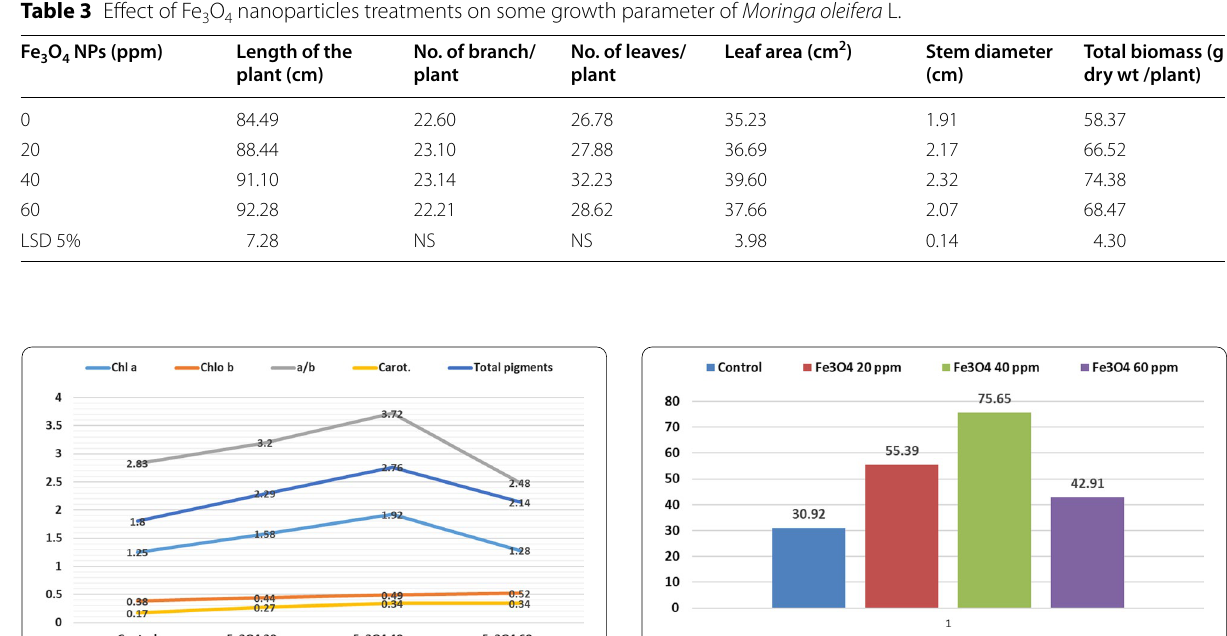
Fig. 2 Effect of foliar application with Fe 3 O 4 NPs on indole acetic acid content (μ g/g fresh Wt) of Moringa oleifera L (LSD 5%